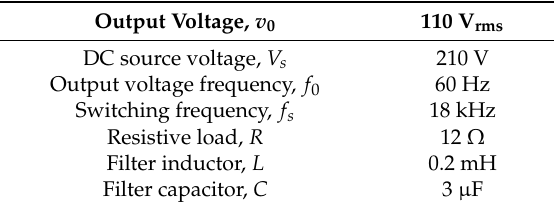
Table 1. Nominal parameters for the full-bridge